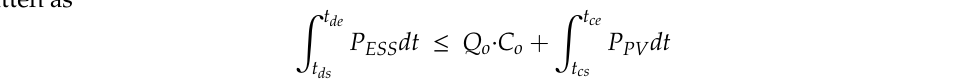
Figure 7. Simulated PV production profile. 6.2 Impact of EV Charging Demand The effect of different EV penetration ratios on the overall power demand of the apartment complex is shown in Figure A3 of the Appendix. To visualize the effect of EV charging demand, the base load profile is also shown in Figure A3. The specific parameter values considered for simulating the EV charging profile were selected as (cid:2020) (cid:3031) = 3.2 and σ (cid:3031) = 0.87 , μ (cid:3002)(cid:3021) = 17 , σ (cid:3002)(cid:3021) = 2.1 , μ (cid:3005)(cid:3021) = 7 , σ (cid:3005)(cid:3021) = 3.4 , SOC limit = 0.2 , A = 1.25, ∆(cid:1846) (cid:3040)(cid:3036)(cid:3041) = 0.5 [h], ∆(cid:1846) (cid:3040)(cid:3028)(cid:3051) = 3.5 [h], SOC F = 0.2, B = 0.33, and C = 1.25. From Figure A3, a noticeable increase in the load demand with EV charging compared to the base load case has occurred during the period of 2 p.m.–11 p.m. In the case of the maximum power demand level, the load demand of the 30% EV penetration ratio case is 39.7% larger than that of the base load case. While the daily average load demand of the 30% EV penetration ratio case is 33.5% larger than the base load case, the impact of EV charging on the overall load demand is rather limited during the period of 0 a.m.–8 a.m. The minimal difference during this period could be explained by the negligible demand for EV charging. The fact that most of the EVs would return to the apartment complex and resume EV charging between 5 p.m. and 10 p.m., as shown in the realistic vehicle arrival data presented in Figure 2b, could also explain the different level of impacts during a 24 h period.